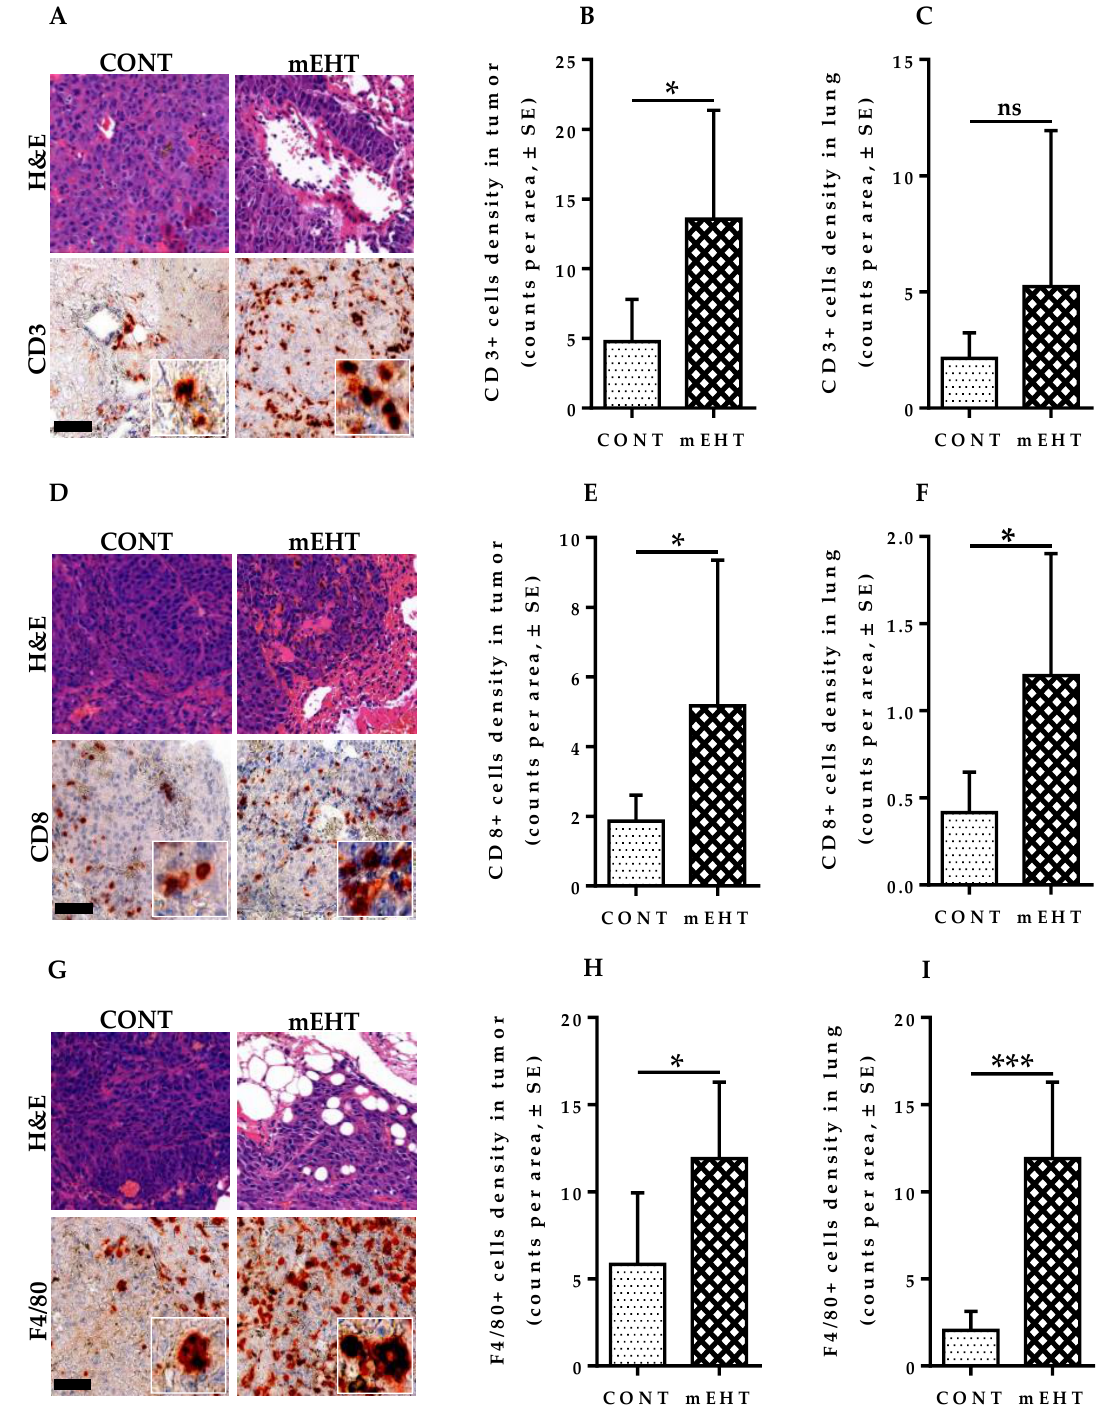
Figure 8. mEHT induced immune cell infiltration in focal metastatic melanoma lesions. ( A ) H&E and CD3 staining of mouse lungs in CONT and mEHT; ( B ) Plot depicting CD3-positive cell density in tumor area in CONT ( n = 6) and mEHT ( n = 7); ( C ) Plot depicting CD3-positive cell density in total lung area in CONT ( n = 6) and mEHT ( n = 7); ( D ) H&E and CD8 staining of mouse lungs in CONT and mEHT; ( E ) Plot depicting CD8-positive cell density in tumor area in CONT ( n = 6) and mEHT ( n = 7); ( F ) Plot depicting CD8-positive cell density in total lung area in CONT ( n = 6) and mEHT ( n = 7); ( G ) H&E and F4/80 positive cell staining of mouse lungs in CONT and mEHT; ( H ) Plot depicting F4/80 positive cell density in tumor area in CONT ( n = 5) and mEHT ( n = 6); ( I ) Plot depicting F4/80 positive cell density in total lung area in CONT ( n = 5) and mEHT ( n = 6). Data represent average ± SEM. ( B , F , H , I ) CONT vs. mEHT, unpaired t -test, ( C , E ) CONT vs. mEHT, Mann–Whitney test, ns = non-significant, * p < 0.05, *** p < 0.001. Scale bar represents 50 μm on all low-power images and 15 μm in their insets. 2.10. mEHT-Treated Lungs Showed No Auxiliary Lung Damage after Six-Time Treatment